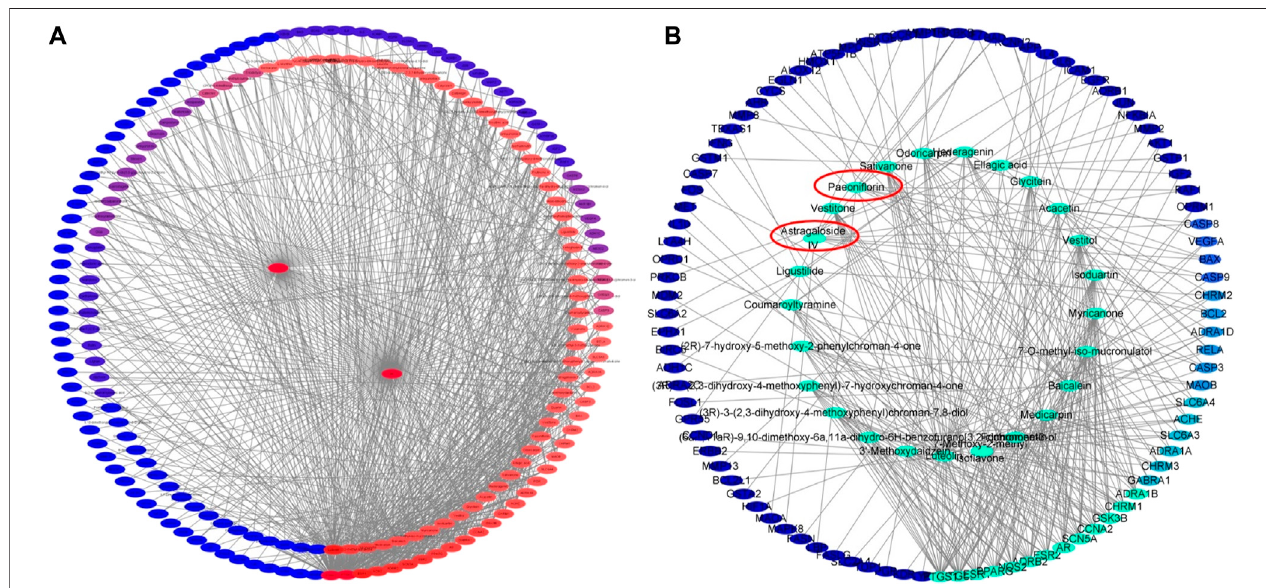
FIGURE 4 | Network analysis of potential active compounds and targets. (A) The drug, active compounds, disease and targets were input into Cytoscape to construct the DMTD diagram, and the colors of the nodes are illustrated from red to blue in descending order of degree values. (B) The top 25 components and their related targets in the DMTD network were selected based on the degree, and the colors of the nodes are illustrated from green to blue in descending order of degree values.